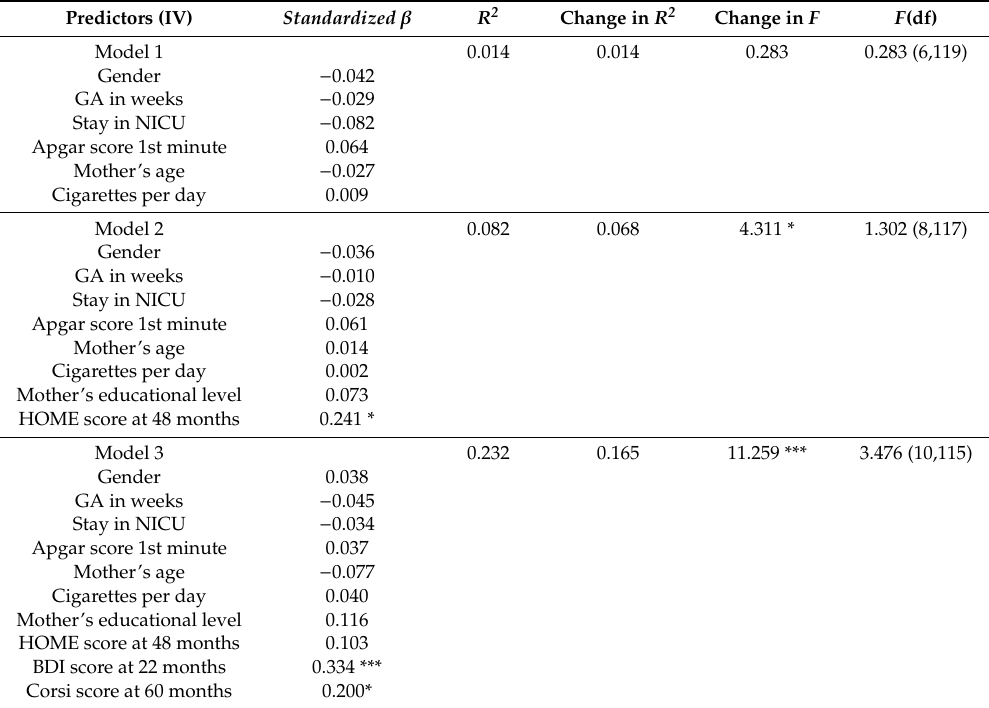
Table 4. Linear Regression: predictors of BDI cognitive scores at 60